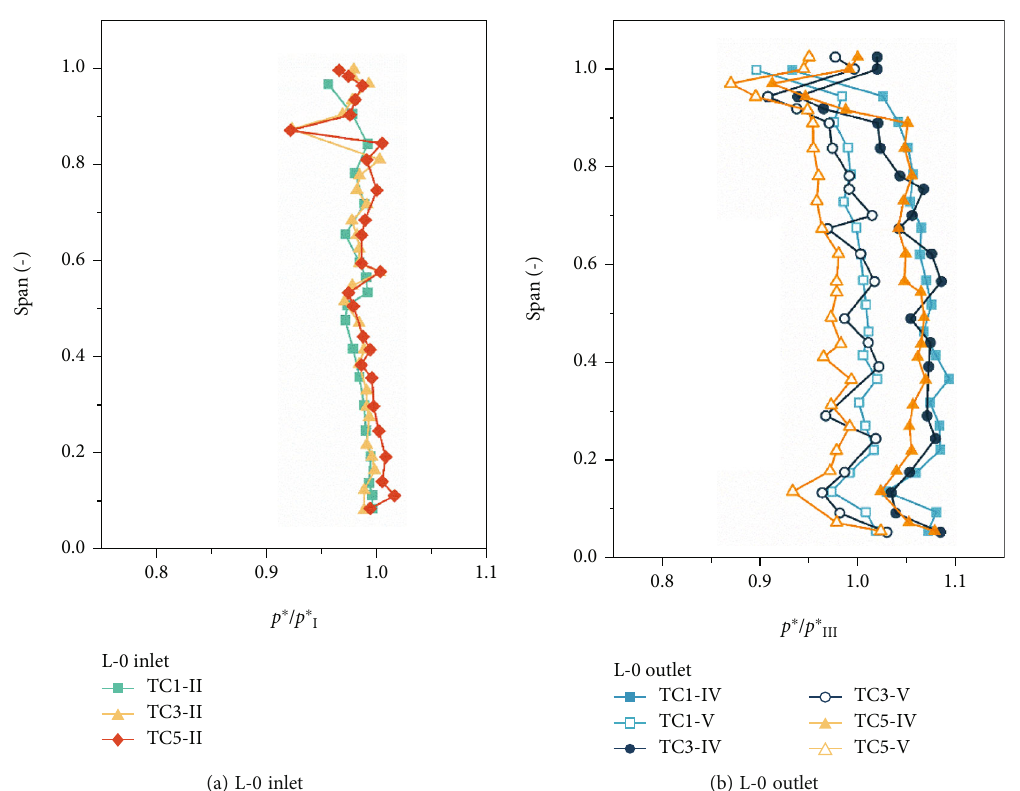
Figure 10: Normalized total pressure distribution at the L-0 inlet and